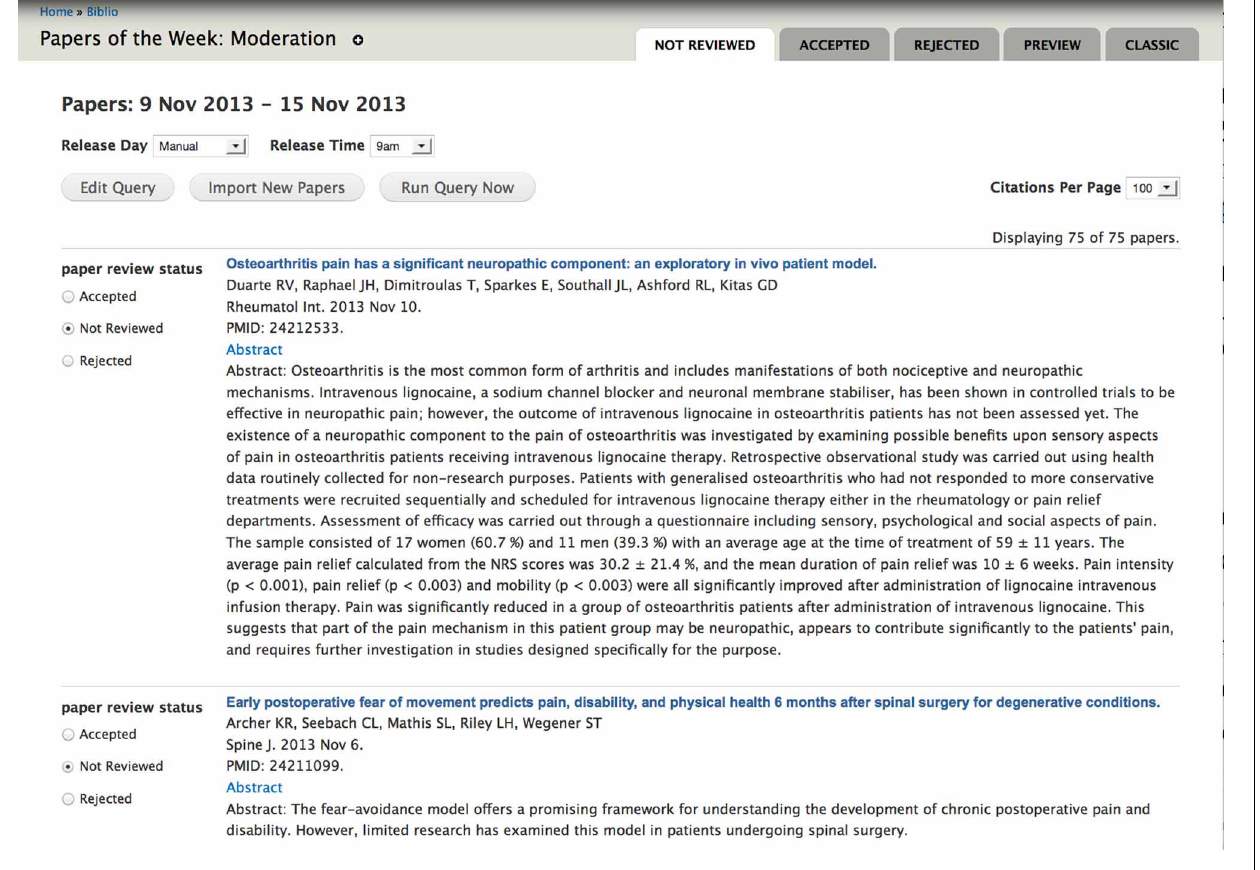
FIGURE 1 | Papers of the Week moderation queue. Papers are imported nightly from NLM PubMed using a tailored query. Editors are presented with an easy-to-use interface to accept or reject the